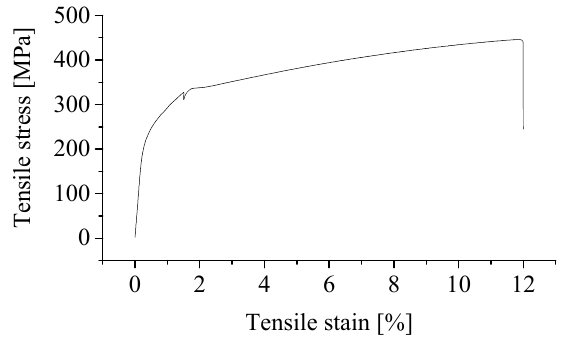
Figure 6. The tensile curve of the sample (laser power of 300 W, scan speed of 900 mm/s and overlap rate of 0.35).